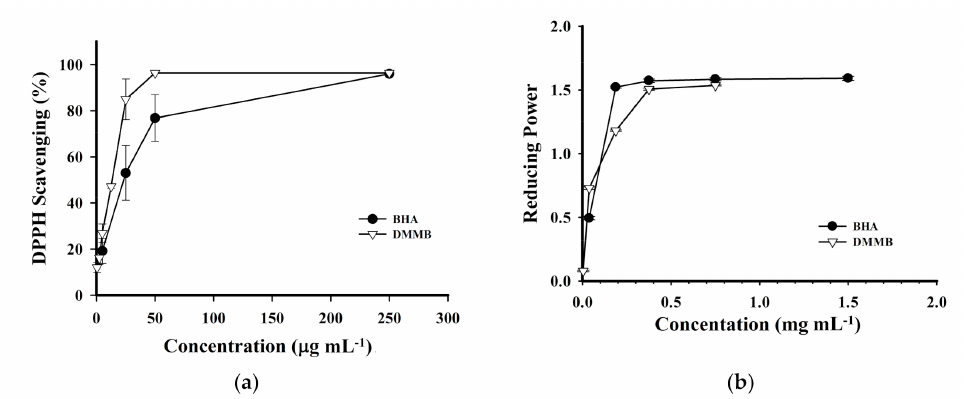
Figure 5. Antioxidant activity assays of DMMB. ( a ) DPPH free radical-scavenging effects. ( b ) Reduc- ing power. Each value is expressed as the mean ± SD ( n =